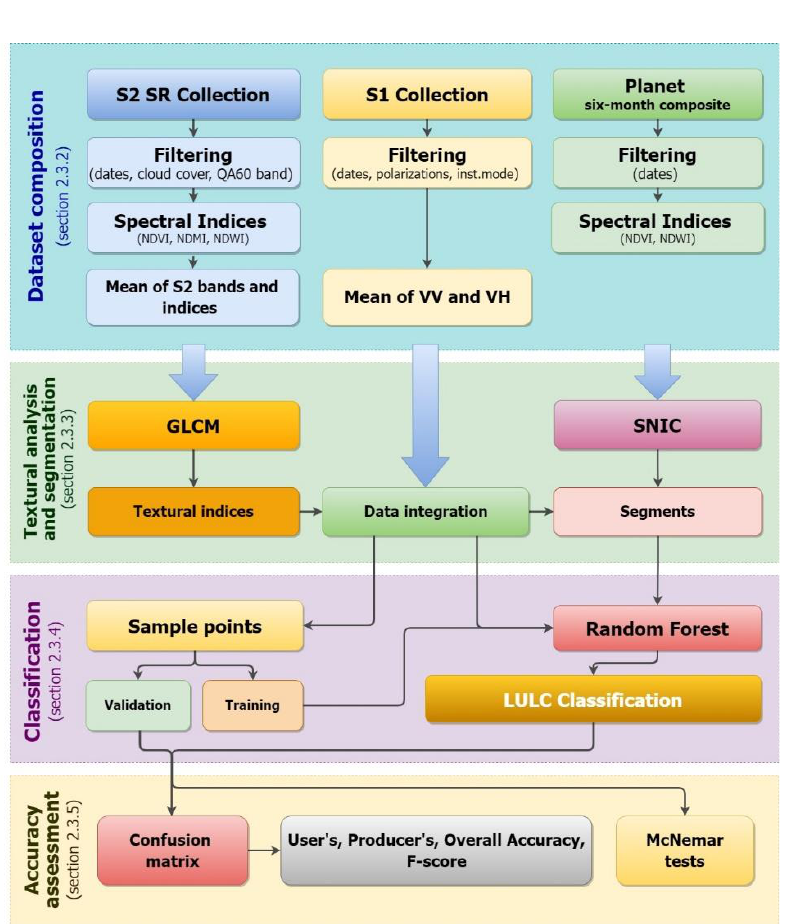
Figure 2. The methodological workflow of the research.